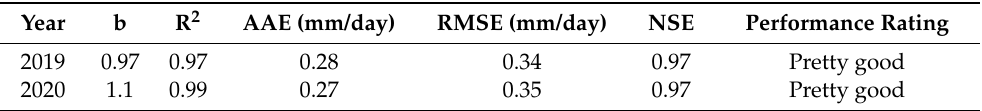
Table 4. Performance of the SIMDualKc model for predicting evapotranspiration in the DCHD- cultivated apple orchard in 2019 and